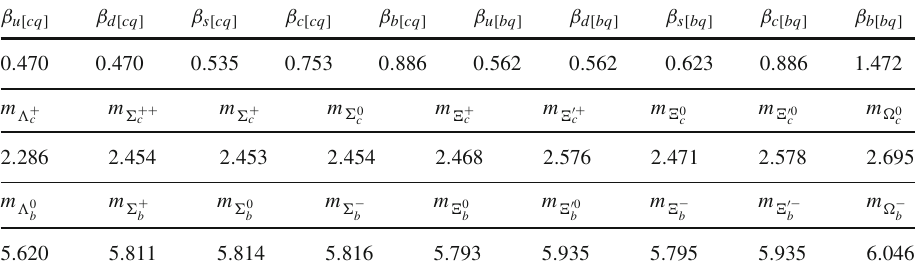
Table 7 The shape parameters β in the Gaussian-type wave functions Eq. (17) and the final baryon masses (in units of GeV)